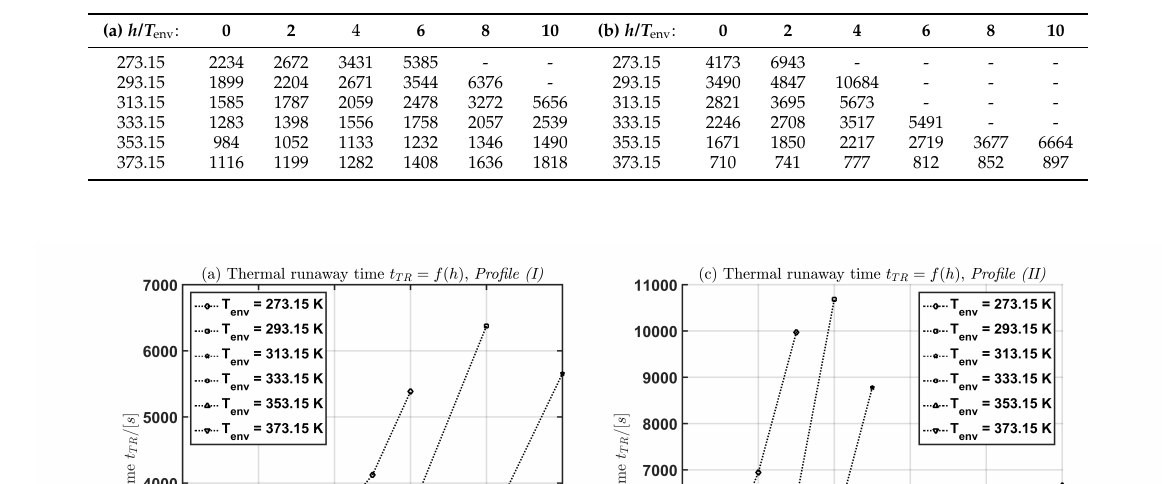
Table 3. Thermal runaway time t TR / [ s ] with respect to heat transfer coefficient h and the environment al temperature T env . (a) Profile (I) , (b) Profile (II) .